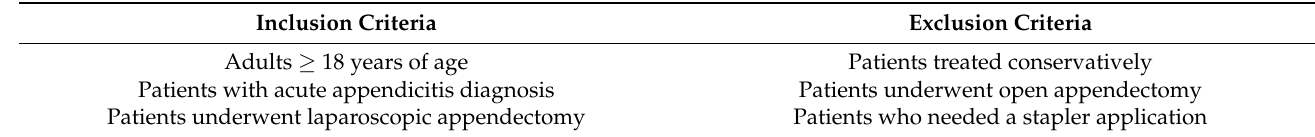
Table 1. Inclusion and exclusion criteria for a retrospective